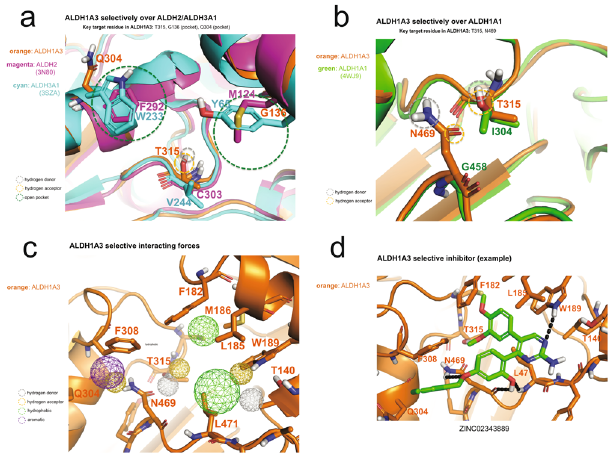
Fig. 4 Structural comparison among different human ALDHs. a Relevant structural differences in the substrate access tunnel between ALDH1A3 and the isoforms ALDH2 and ALDH3A1. In the zoomed-in region, the green dotted line circles highlight the bulky residues that, in ALDH2 and ALDH3A1, decorate the substrate access tunnel and are painted in magenta and cyan, respectively. The structurally equivalent residues in ALDH1A3, T315 and G136, are in orange. Yellow and gray dotted line circles highlight the site of potential hydrogen bond donors and acceptors, respectively, and include T315, one of the two unique ALDH1A3 residues in the enzyme active site. b Structural comparison between ALDH1A1 and ALDH1A3 in the catalytic pocket revealed two major amino acid substitutions. Amino acid residues T315 and N469 in ALDH1A3 are replaced by I304 and G458, respectively, in ALDH1A1. Optimal structural superposition of ALDH1A3 (PDB code: 5FHZ) in orange and the two amino acids identi fi ed as contributors to selectivity are indicated: N469 and T315 in ALDH1A3 are drawn in orange and the structurally equivalent G458 and I304 in ALDH1A1 in green. Yellow and gray dotted line circles highlight the site of potential hydrogen bond donors and hydrogen bond acceptors, respectively. c The selective interacting force within the catalytic site of ALDH1A3. Yellow and gray dotted line circles highlight the site of potential hydrogen bond donors and acceptors, respectively. Green and violet dotted lines point up a zone with hydrophobic and aromatic possible interaction. d The example of the in silico design/screening of highly selective ALDH1A3